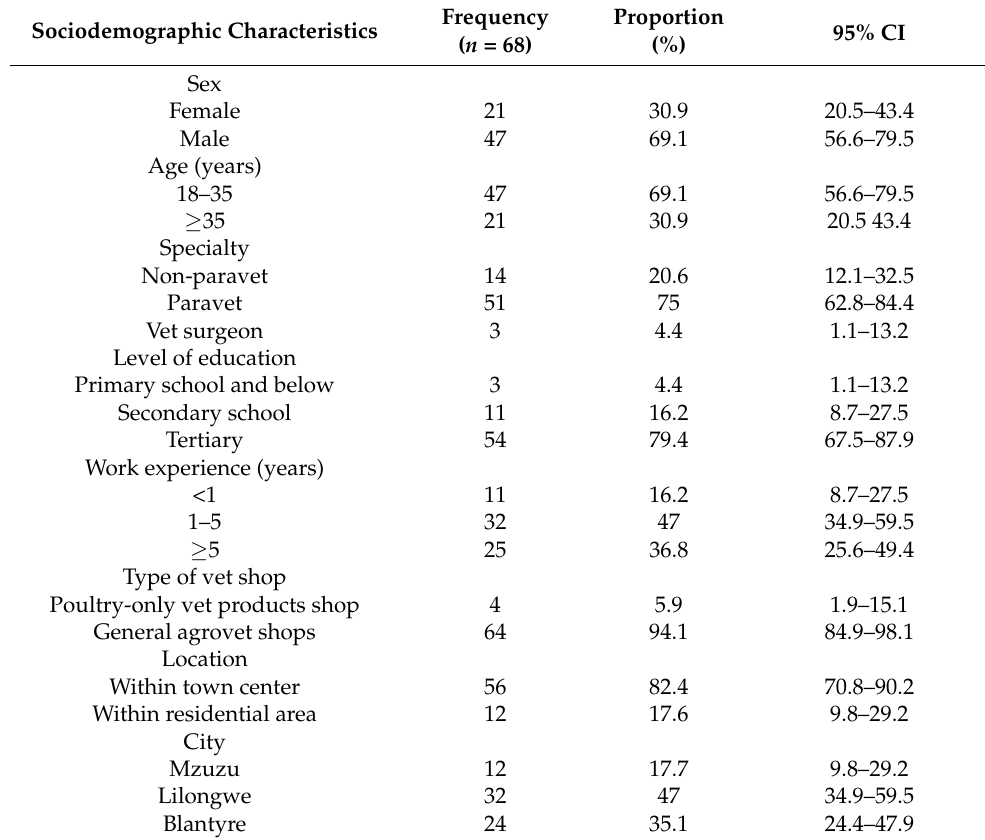
Table 1. Sociodemographic characteristics of study